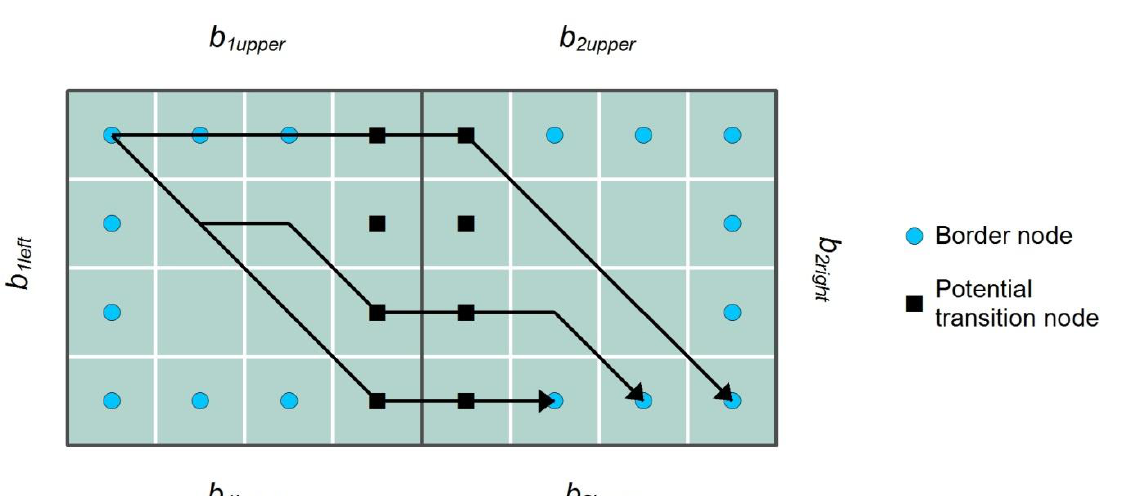
Figure 2. The principle used to determine accessibility scores. For illustration purposes, paths are shown only between the border cell at the top left corner of the first block and cells along the opposite, lower border of the neighboring block. The calculated score indicates the potential transitions which will most likely be shared by different paths, and the transition is placed at the position of the highest score (in the case of a tie, the centermost candidate is